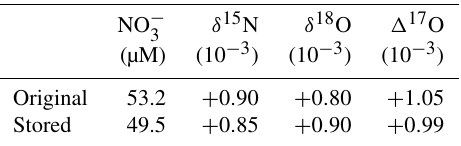
Table A2. Comparison of both concentration and isotopic compo- sitions ( δ 15 N, δ 18 O, and (cid:49) 17 O) between the original stream wa- ter sample and that being stored under the room temperature for 2 weeks without